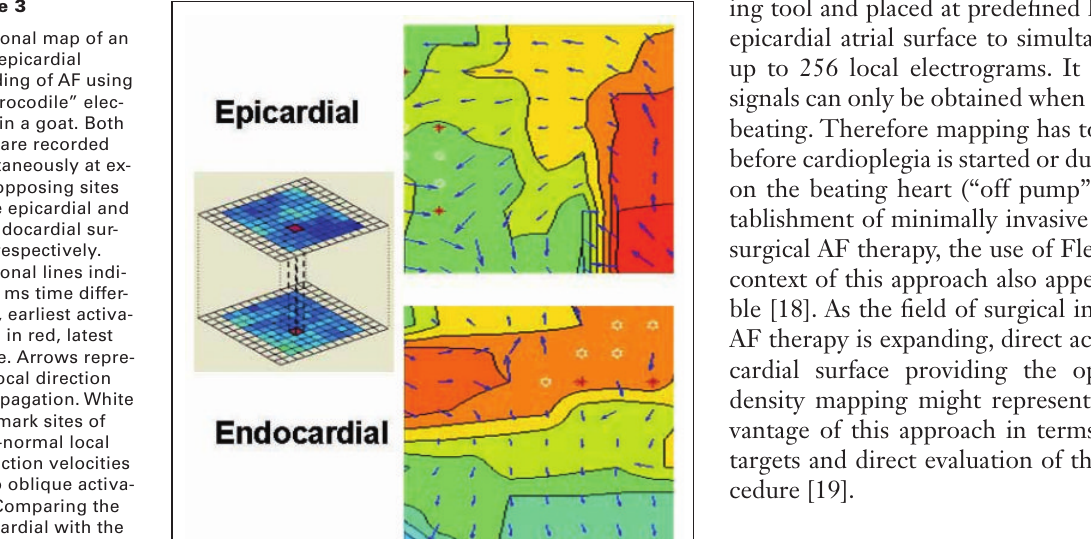
Custom-made multi-electrode mapping arrays (MEAs): Left: “Spoon” 256 electrodes, spatial resolution 2.4 mm, used for mapping of the atrial free wall in animals and humans. Middle: “Crocodile” 246 electrodes, spatial resolution 1.6 mm, used for simultaneous endo-epicardial mapping of the atrial free wall in animals. By inserting the lower part of the clamp into the atrial cavity, the atrial wall between the two MEAs can be mapped simultaneous endo- and epicardially. Right: Single use Flex-MEA, 256 electrodes, spatial resolution 1.5 mm, used for high resolution epicardial contact mapping in patients during cardiac surgery.